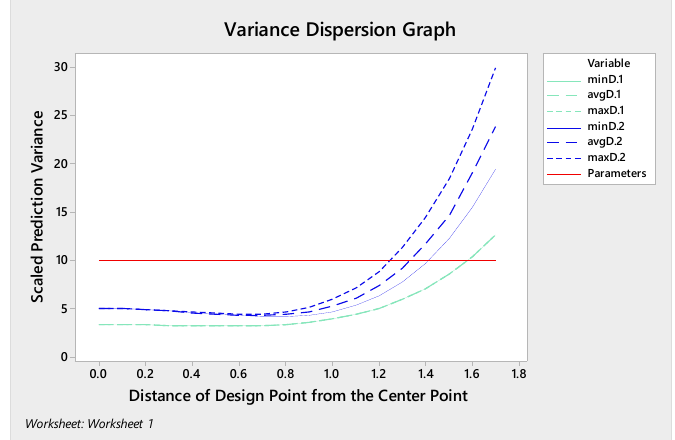
Figure 23. Variance dispersion graph for the CCD and BBD experiment.